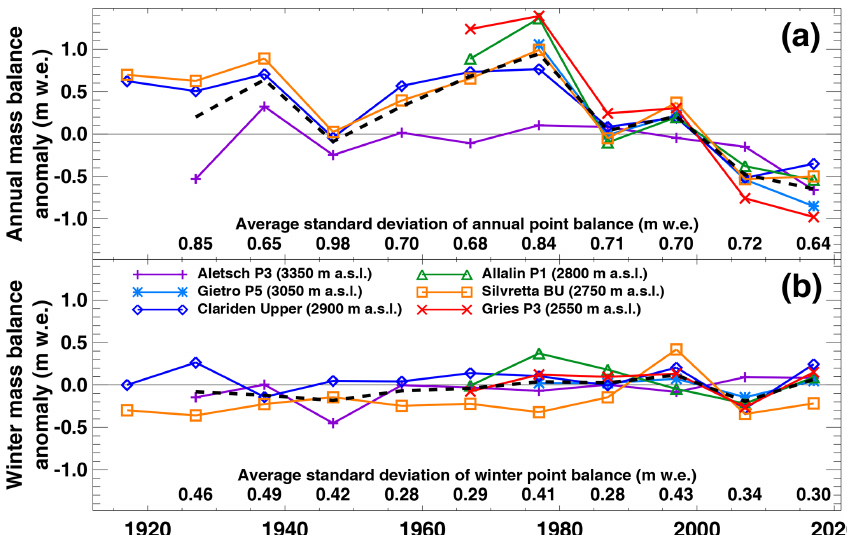
Figure 8. Anomaly in (a) annual and (b) winter balance relative to 1981–2010 observed at six selected sites with complete long-term observations, averaged over 10-year periods. The dashed line refers to the average anomaly of all selected sites. Note that the approach by Huss et al. (2009b) has been used to homogenize the point mass balance observations to common periods of the year (see text for